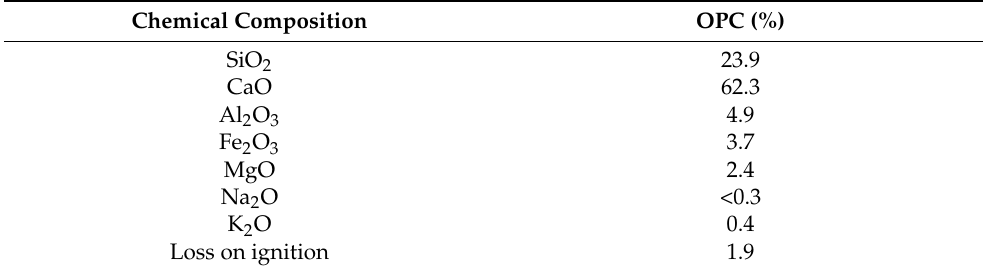
Table 3. Chemical compositions of the